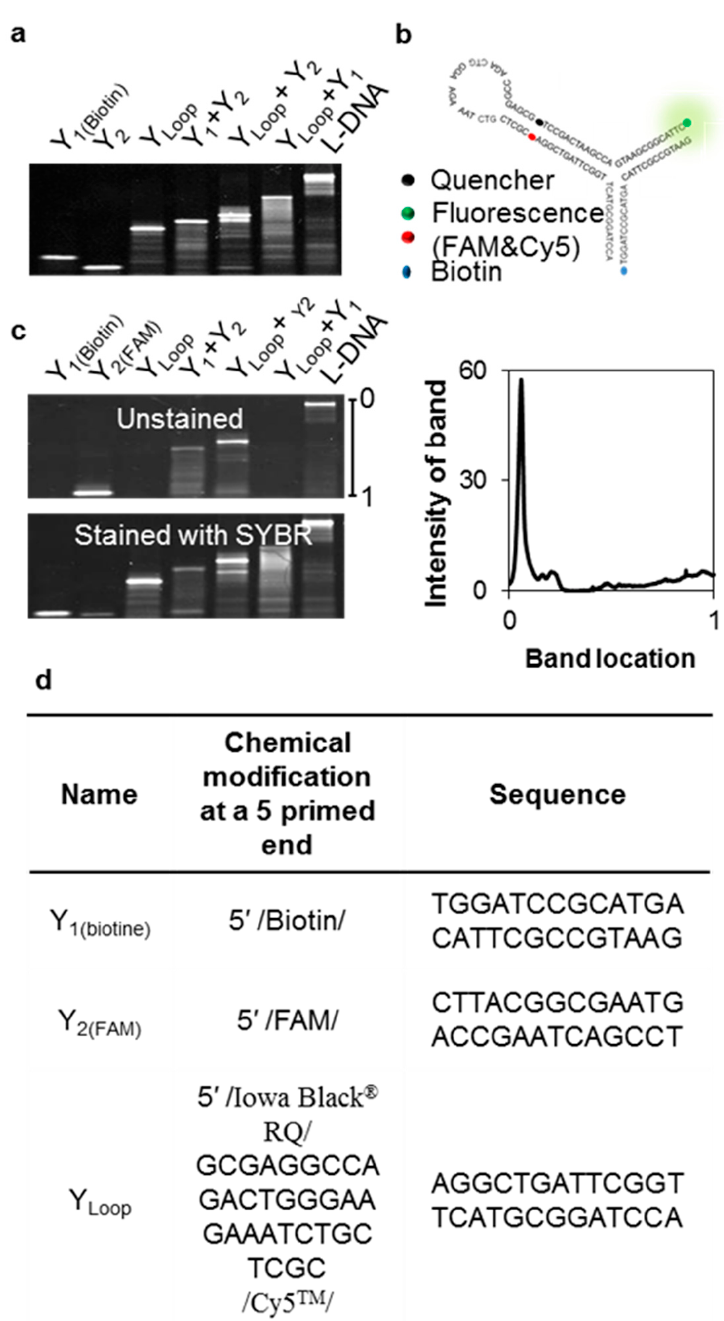
Figure 3. Evaluation of state-runs of L-DNA by single-strand conformation polymorphism (SSCP) analysis. ( a ) SSCP analysis of L-DNA and its partial constructs. Sequential build-ups of L-DNA were subjected to 15% polyacrylamide gel electrophoresis at 100 V for 2 h, followed immediately by specific staining with 2 µ g/mL SYBR gold for 30 min. ( b ) Structural form of as-predicted L-DNA. ( c ) Gel electrophoretic image of a set of FAM-labeled L-DNAs. FAM-labeled single-stranded DNA fragments were present in all L-DNAs. After fluorescence intensity measurements, the yield of L-DNA was calculated using TotalLab Quant gel quantification software. Minimum profile was then used as a single background; the total yield of synthesized L-DNA was 62.6%. ( d ) Sequence information for the fragments used in this